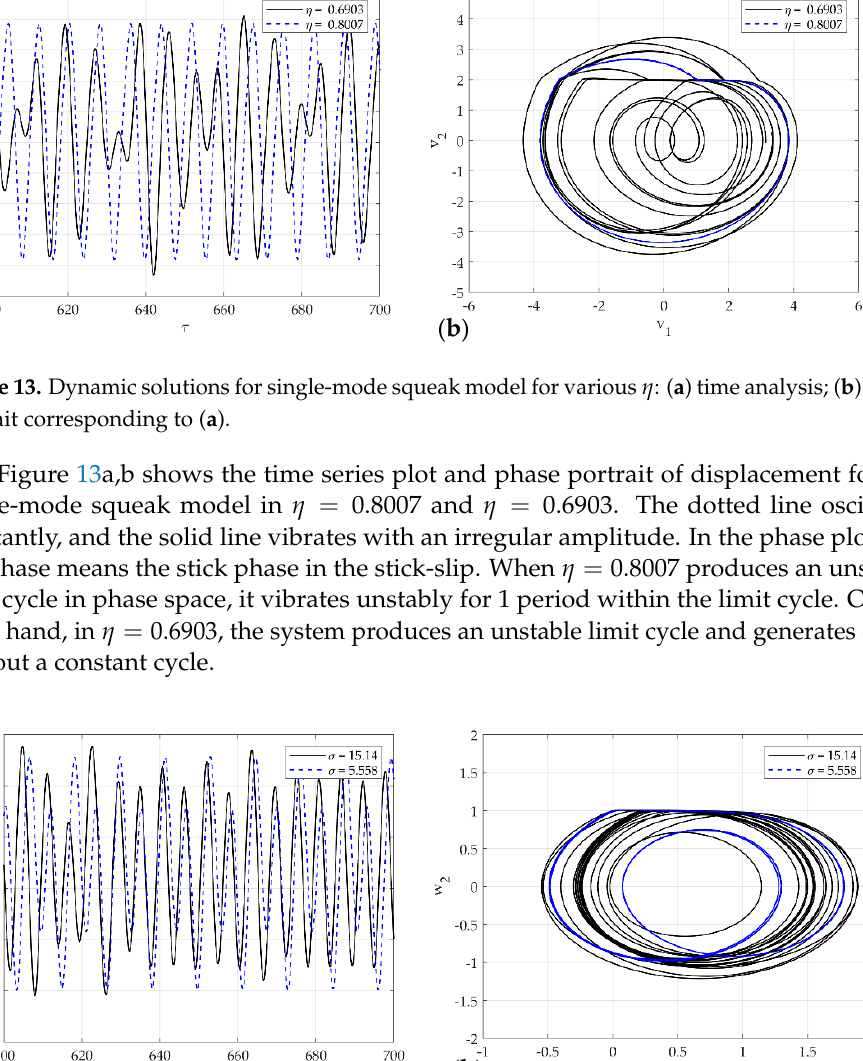
Figure 12. Dynamic solutions for the rattle model for various η : ( a ) time analysis; ( b ) phase portrait corresponding to ( a ).